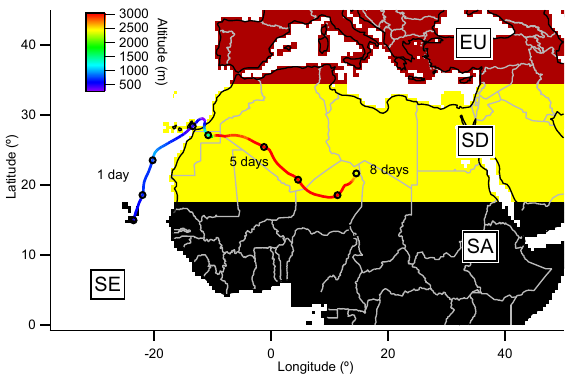
Figure 6. An example back trajectory (with endpoint at 00:00UTC, 11 August at the ground-based site) and calculation of transport days over various land surface types for this back trajectory, sep- arated into the defined land surface type